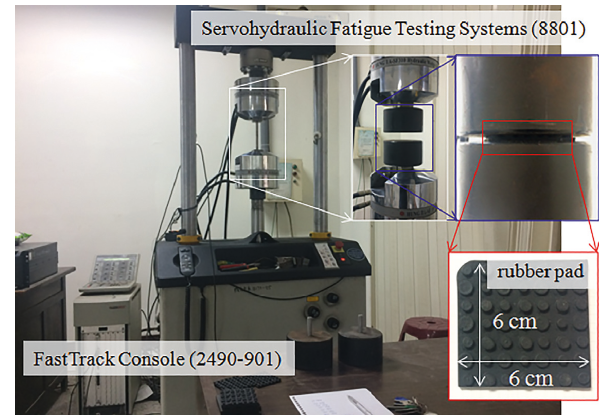
Figure 2: Experimental setup and the 6 cm by 6cm rubber pad 1 )